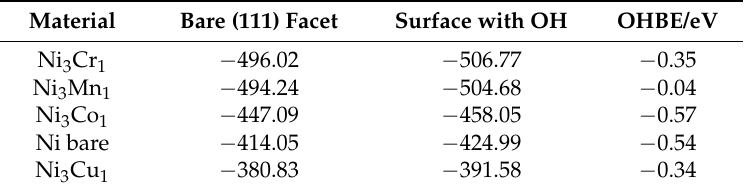
Table A4. Ground state energies of bare and with OH at (111) facet (1/16 ML) supercell 2 × 2 × 1 and calculated OHBE (all energies are in eVs).